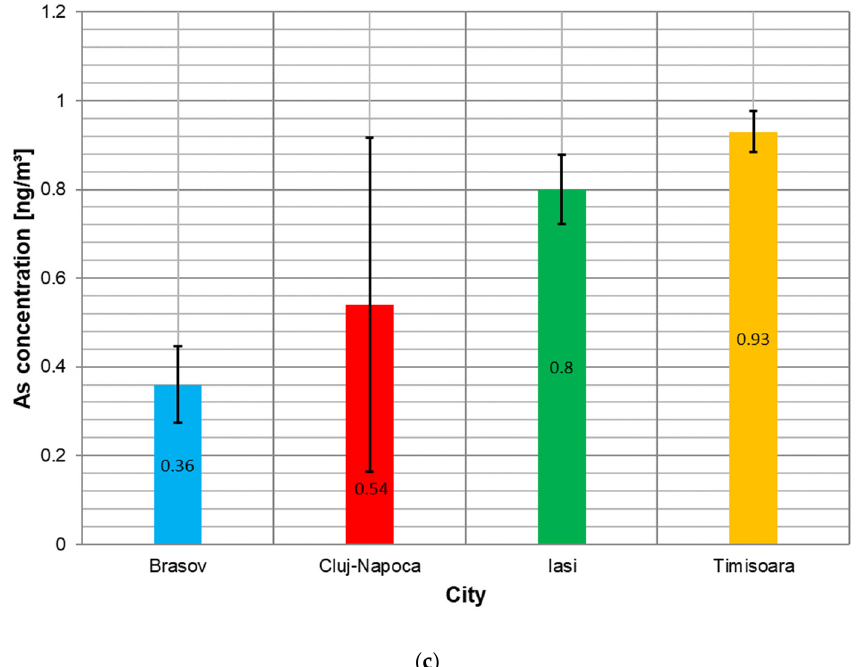
Figure 8. ( a ) Air quality aggregate index for PM 2.5 with standard error (2011–2021); ( b ) air quality aggregate index for CO with standard error (2011–2021); ( c ) air quality aggregate index for As with standard error (2011–2021).